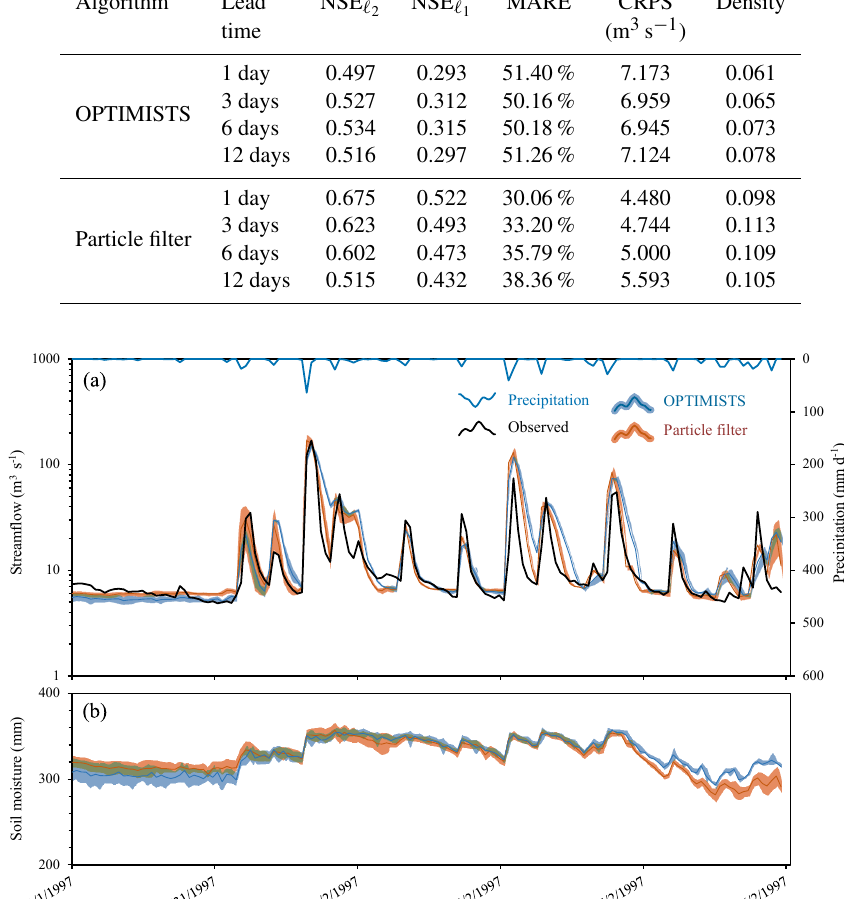
Figure 4. Comparison of 6-day lead time probabilistic streamflow (a) and area-averaged soil moisture (b) forecasts between OPTIMISTS ( (cid:49)t = 7 days; three objectives: NSE (cid:96) , MARE, and likelihood; n = 30; no optimization; and D-class kernels) and a traditional PF ( n = 30) 2 for the Blue River. The dark blue and orange lines indicate the mean of OPTIMISTS’ and the PF’s ensembles, respectively, while the light blue and light orange bands illustrate the spread of the forecast by highlighting the areas where the probability density of the estimate is at least 50% of the density at the mode (the maximum) at that time step. The green bands indicate areas where the light blue and light orange bands